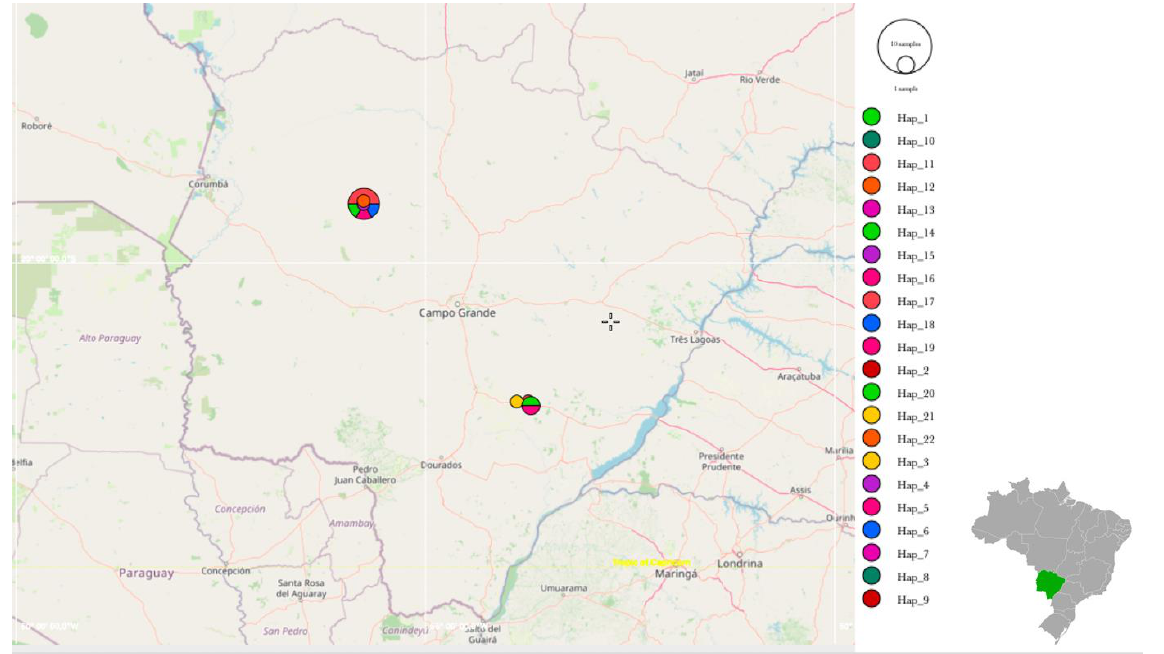
Figure 6. Representation of the genotype distribution along all sampling areas. Map was constructed using PopART software based on GPS coordinates data of each sampling.